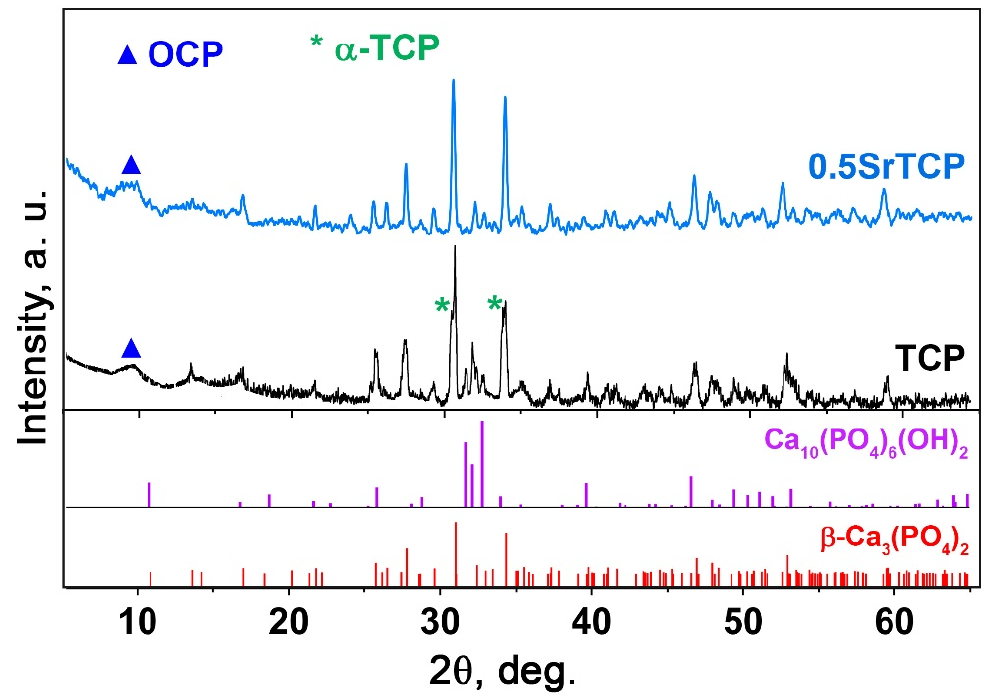
Figure 6. PXRD patterns of TCP and 0.5SrTCP ceramics calcined at 1100 °C and kept in the saline solution for 21 days.